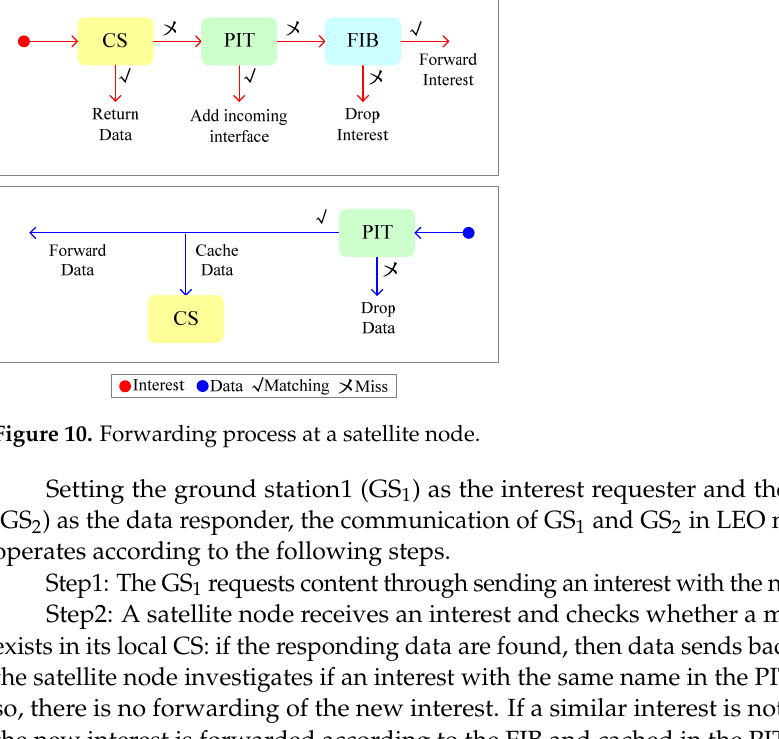
10 of 21 Figure 9. Packet architecture. For performing the interest and data forwarding, each satellite node needs to main- tain three functional components: forwarding information base (FIB), pending interest ta- ble (PIT), and content store (CS) [53]. Moreover, the interest and data forwarding steps in a satellite node are described in Figure 10. Setting the ground station1 (GS 1 ) as the interest requester and the ground station2 (GS 2 ) as the data responder, the communication of GS 1 and GS 2 in LEO mega constellation operates according to the following steps. Step1: The GS 1 requests content through sending an interest with the name of the content. Step2: A satellite node receives an interest and checks whether a match data already exists in its local CS: if the responding data are found, then data sends back GS 1 . Other-